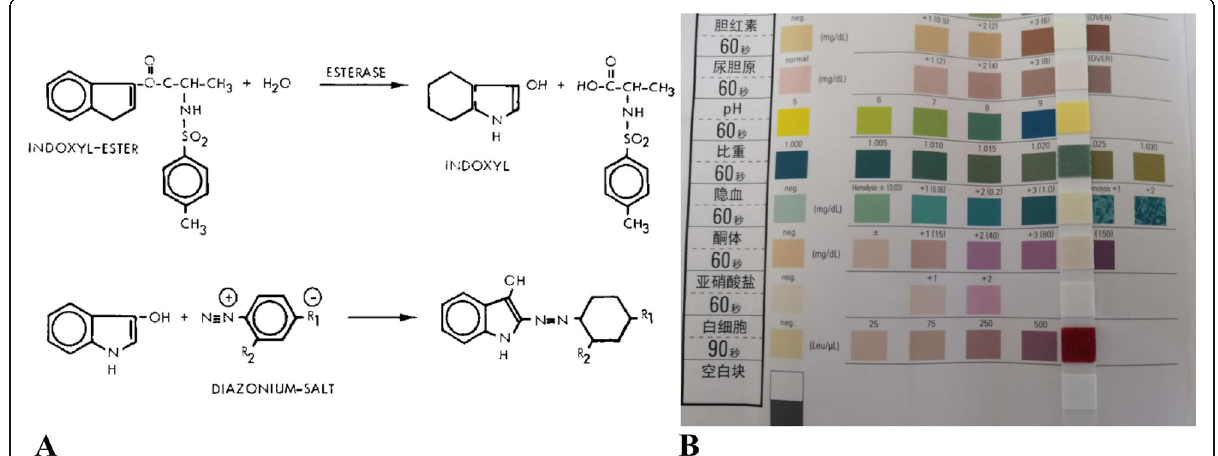
Fig. 1 a Molecular formula of leukocyte esterase [12]. b Detection of leukocyte esterase test strips (dry chemical